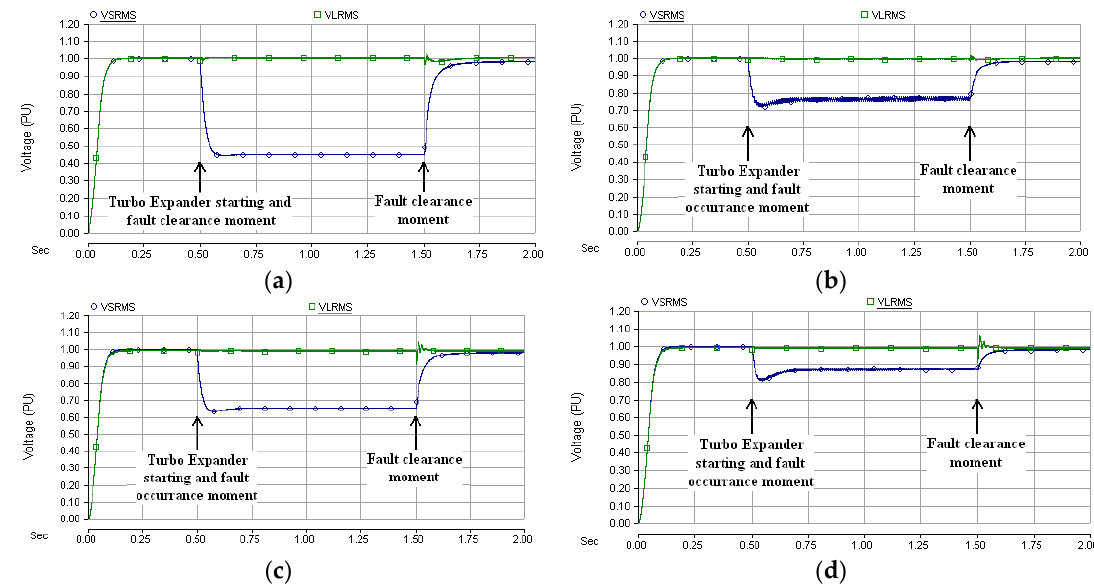
Figure 7. The DVR performance at point B: ( a ) Scenario 5; ( b ) Scenario 6; ( c ) Scenario 7; and ( d ) Scenario 8.